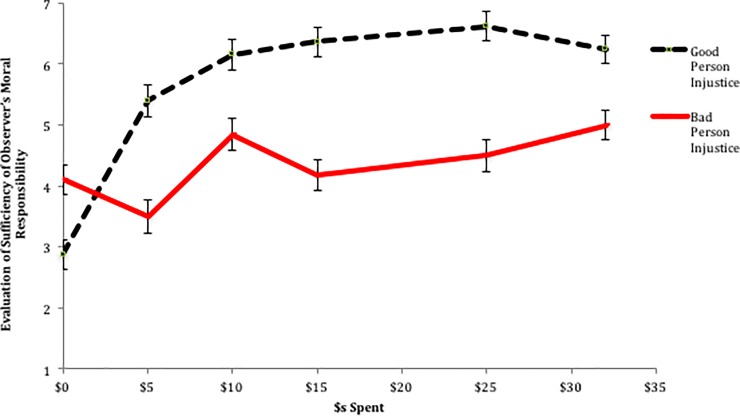
Study 3 evaluation of sufficiency of observer’s moral responsibility.Error bars represent standard errors.